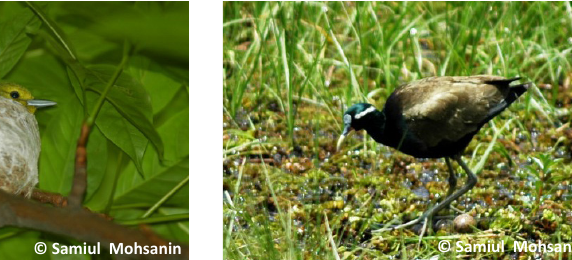
Image 15. Bronzed-winged Jacana with nest